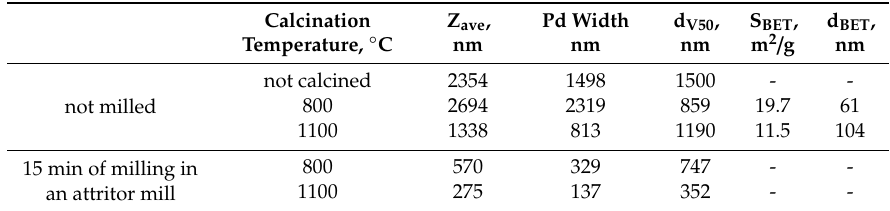
Table 1. Particle size measured by method of dynamic light scattering (DLS) and calculated from BET specific surface area of yttria powders obtained by using the SCS method (Z ave —cumulants mean, Pd—polydispersity width, d V50 —median diameter of the particle size distribution, S BET —specific surface area, d BET —BET equivalent spherical particle diameter).